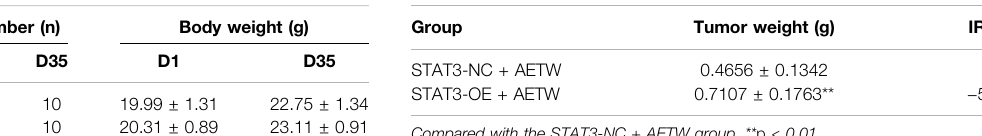
TABLE 7 | Tumor weight from mice of the two experiment groups (STAT3-NC + AETW, STAT3-OE +